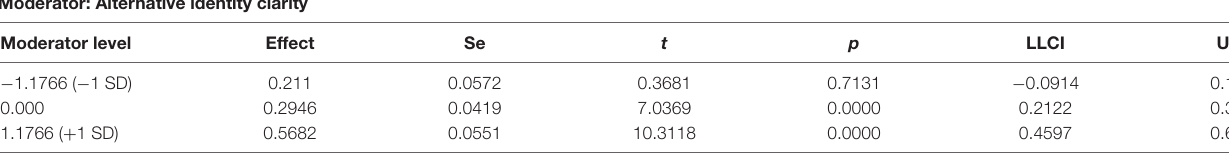
TABLE 5B | Results of testing the alternative identity discrepancy’s moderating